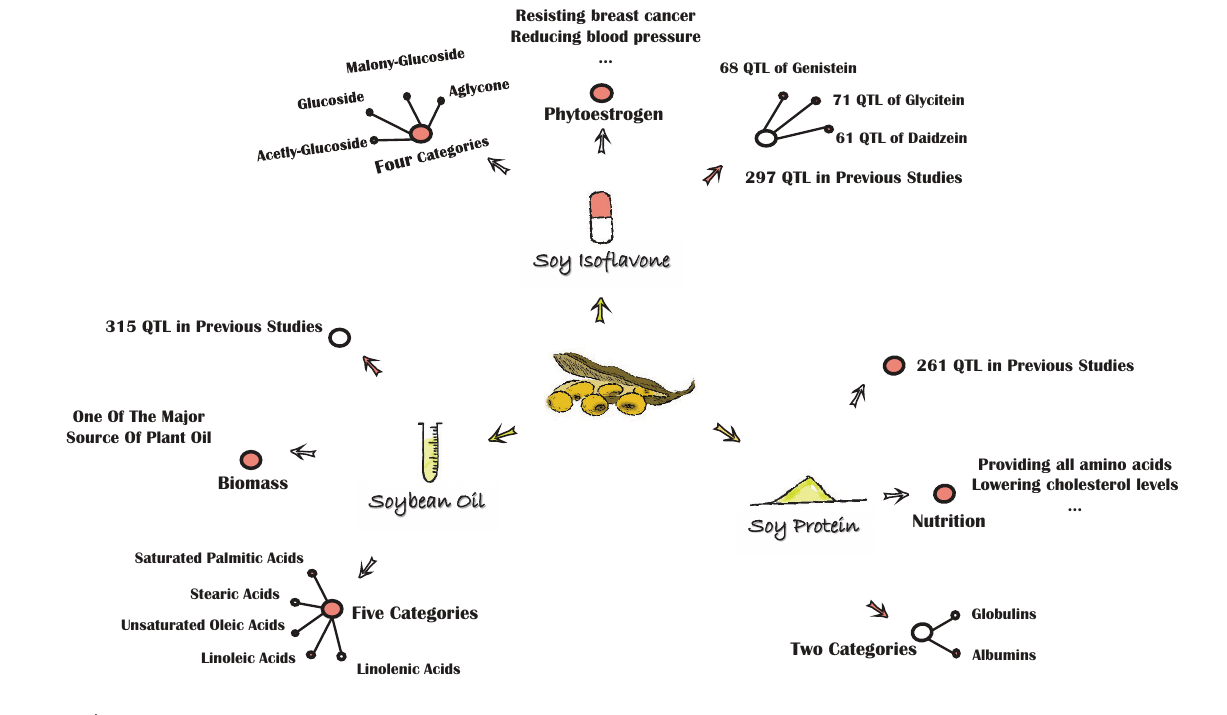
FIGURE 1 | The background of major quality traits in